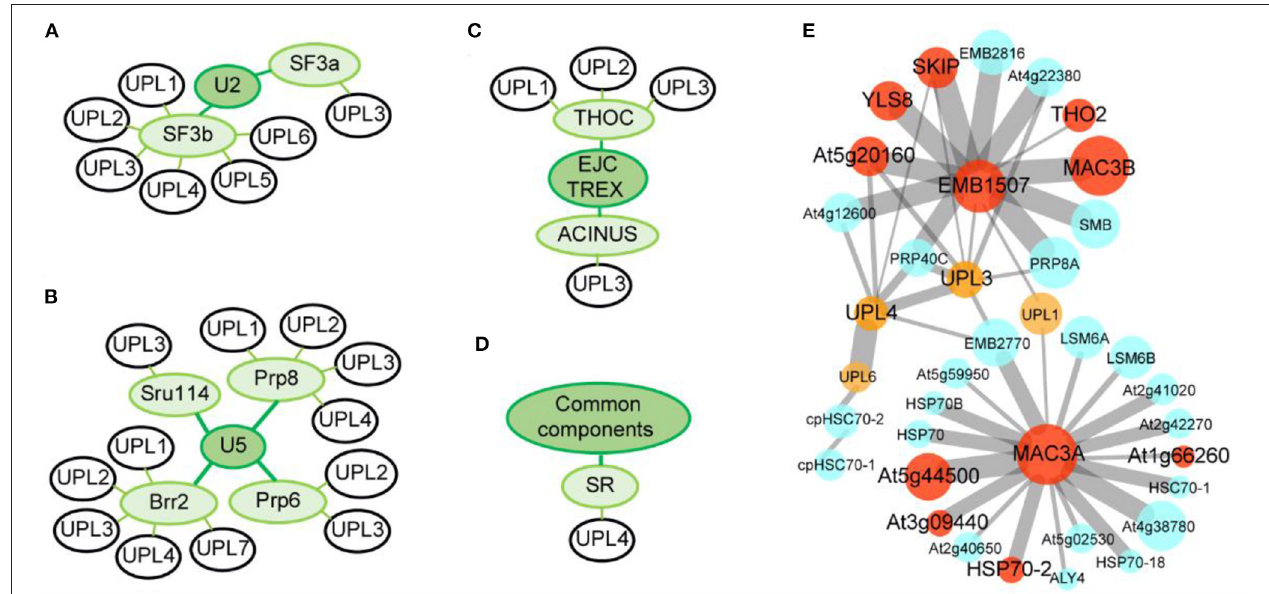
FIGURE 3 | Relationship between spliceosomal components and HECT E3s. (A–D) Co-expression networks of HECT E3s family members with spliceosomal components. Green colored circles represent established spliceosomal components, and black-outlined circles represent HECT E3s. Proteomic analysis of spliceosomal components in the upl3 and the upl4/upl3 double mutants (Lan et al., 2022; unpublished data). (E) Red circles show upregulated genes, yellow circles show HECT E3s, while blue circles represent no change or undetected genes. Edge width indicates the strength of the relation between two proteins based on STRING database, (https://string-db.org/cgi/input?sessionId=HOnM9xTdLFXCandinput_page_active_form=multiple_identifiers), and editing through Cytoscape software.